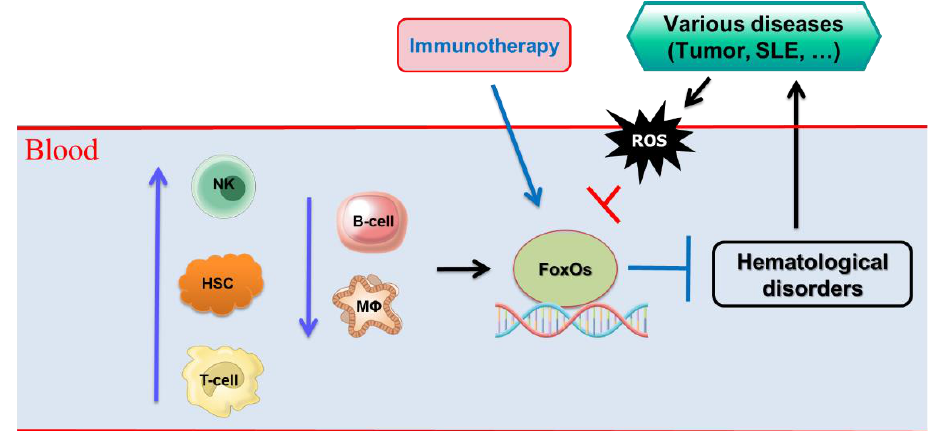
Figure 2. Various cell types involved in hematological disorders through FoxO transcription factors. T-cell, T lymphocyte; B-cells, B lymphocytes; NK cells, natural killer cells; HSCs, hematopoietic stem cells; MΦ, macrophages , ROS, reactive oxygen species.